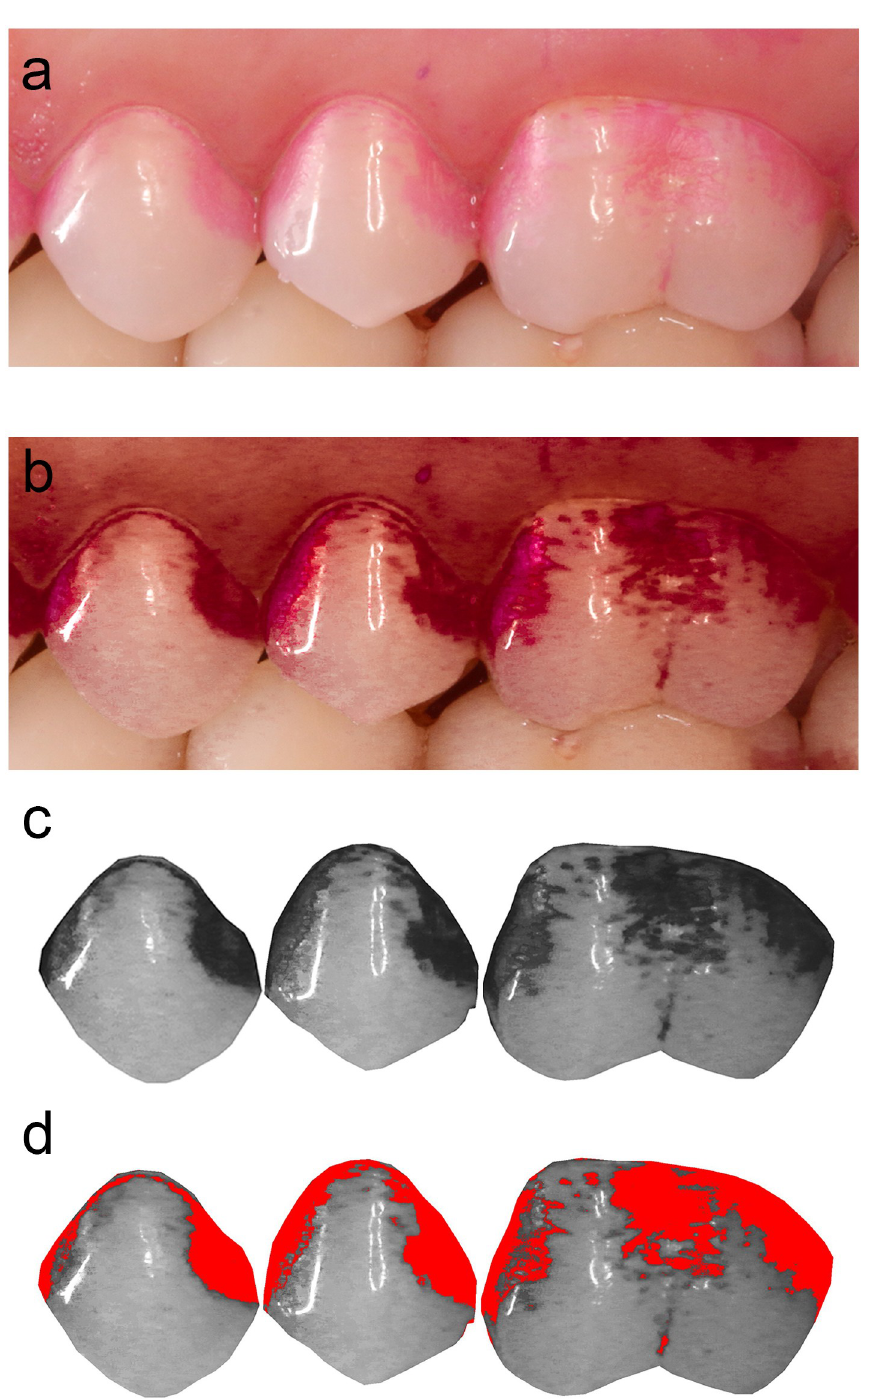
Fig 3. Principle of planimetric analysis. a) Original image; b) same image as (a), but after contrast enhancement; c) cropped tooth surfaces, converted into grey-scale; d) individually marked plaque covered areas, ready for automatic calculation of percentage of the tooth surface covered by disclosed plaque of the total tooth surface (P%D).